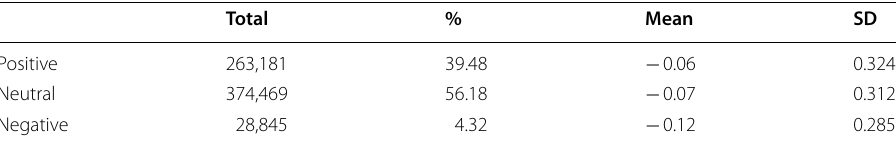
Table 2 Sentiment